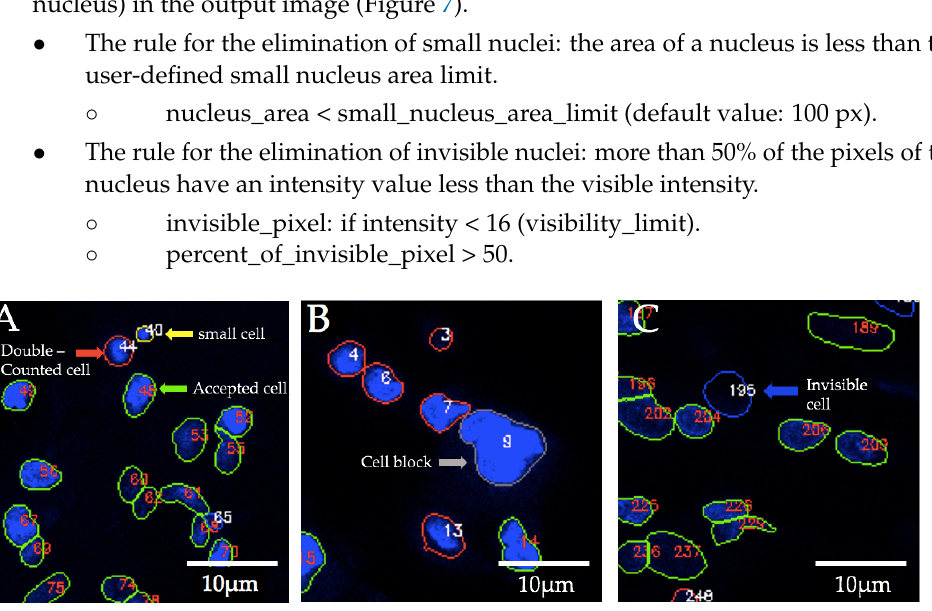
Figure 7. Images with cell nucleus borders outlined in different colors. The green outline indicates accepted cell nuclei that passed through all post-processing steps. The red outline represents double- counted cells concerning the previous or next projection; yellow represents a small nucleus ( A ). Blue depicts invisible cell nuclei and gray represents a cell nucleus block ( B , C ). Small, double-counted, and invisible cells are removed from the mask list of the related image and are not considered in the next